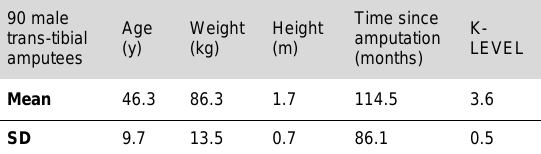
The mean values of OWT were: ECW=0.195±0.039